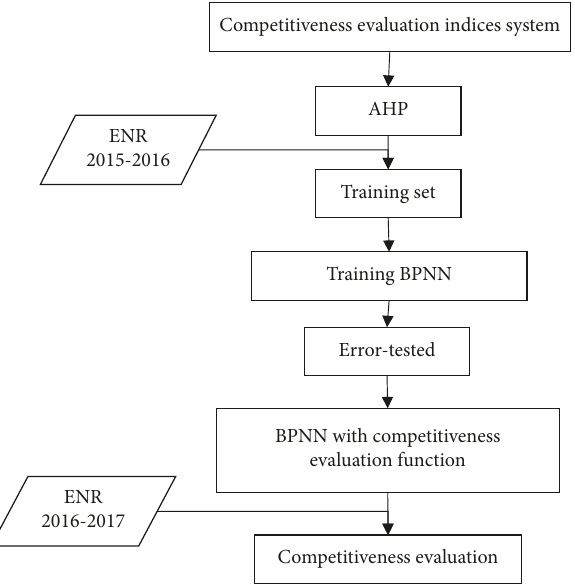
Figure 1: Competitiveness evaluation model of HSR construction Table 1: Statistical results of competitiveness evaluation indices. Indices